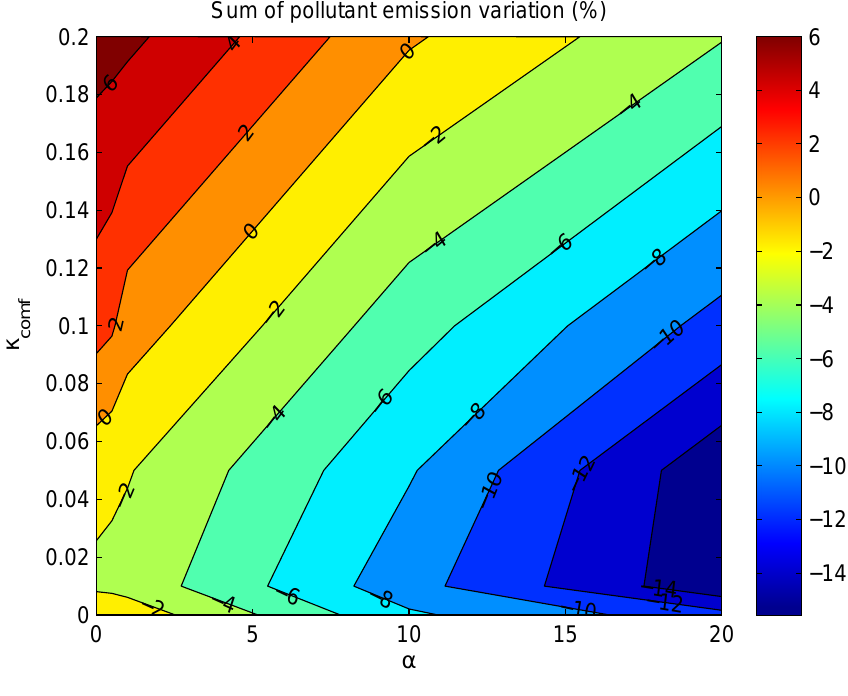
on the pollutant emission variation, relative (%) to the comf = 0 (reference comf